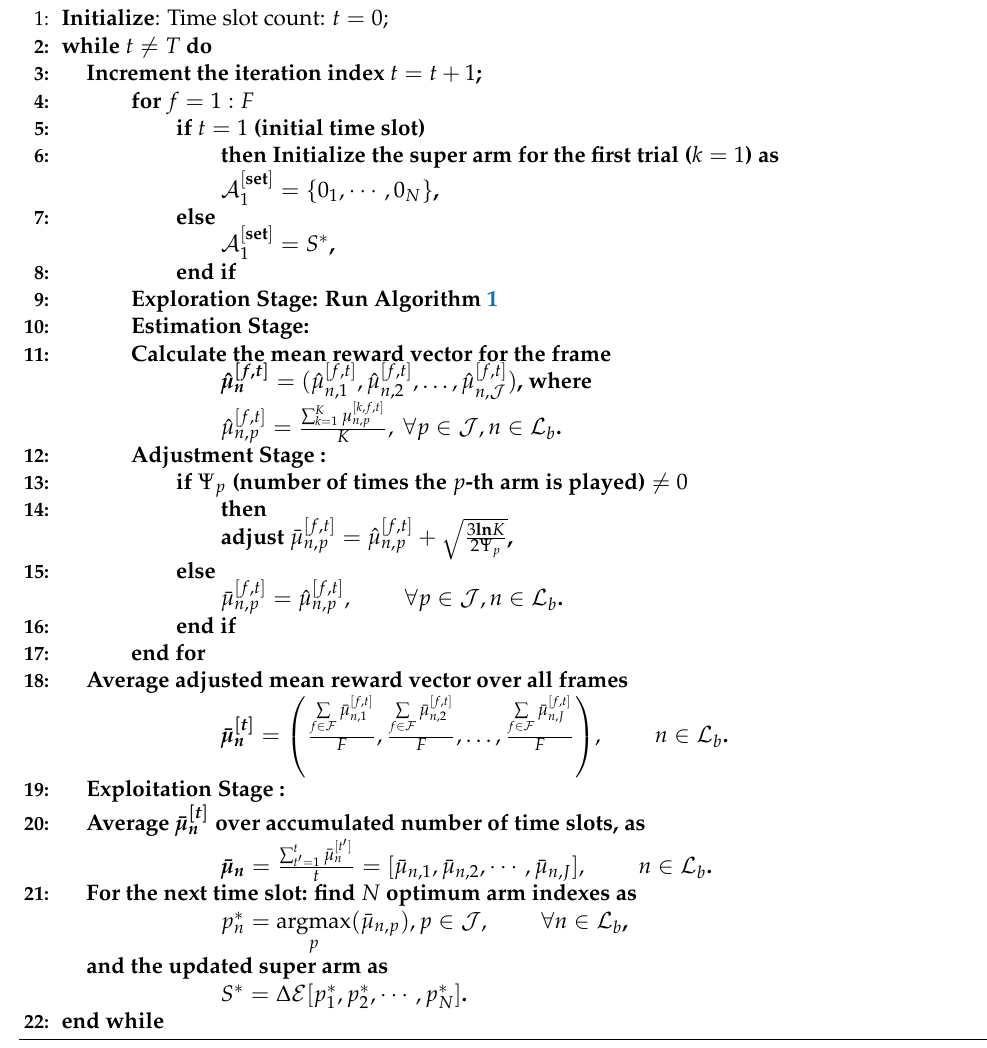
Algorithm 2 Main Online Learning